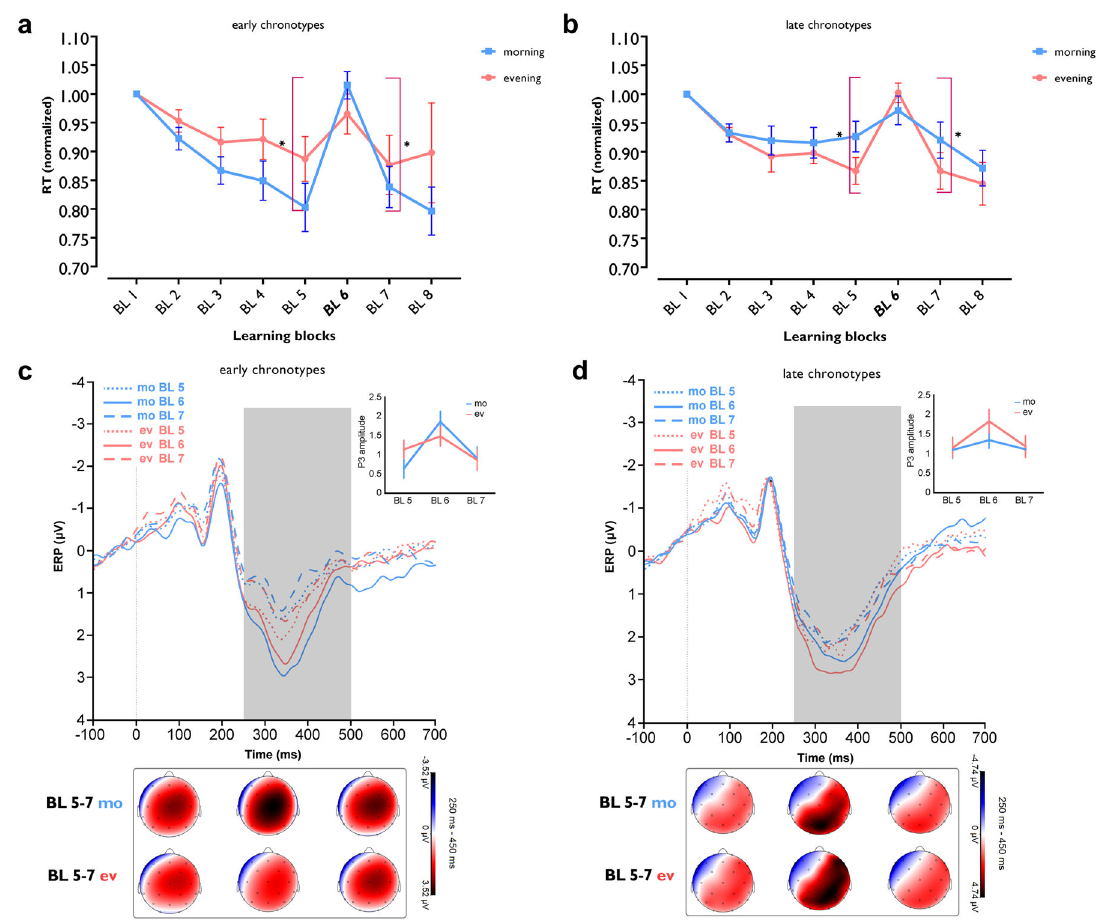
Fig. 4 Chronotype affects motor learning performance and ERP correlates. Behavioral and electrophysiological data were analyzed using a mixed- factorial design with repeated measures ANOVA (see Table 3). a , b The RT difference between blocks 6 – 5 mostly exclusively represents sequence learning. In ECs, the RT difference between these blocks was signi fi cant both in the morning and evening ( t morning = 5.70, P < 0.001, t evening = 2.93, P = 0.010), but blocks 6 – 5 RT difference in the morning vs evening was signi fi cantly larger ( t = 2.90, P = 0.012). In LCs, the respective RT difference was signi fi cant both in the evening and morning ( t evening = 8.78, P < 0.001; t morning = 2.40, P = 0.029), and blocks RT difference was signi fi cantly larger in the evening vs morning ( t = 2.72, P = 0.016). The RT difference between blocks 6 and 7 was signi fi cant in the morning and evening for both ECs ( t morning = 5.53, P < 0.001; t evening = 3.39, P = 0.004) and LCs ( t evening = 5.06, P < 0.001; t morning = 2.43, P = 0.028). Blocks 6 – 7 RT difference in the morning vs evening was only marginally signi fi cant for LCs ( t = 2.11, P = 0.052). Asterisks [*] represent s t atistically signi fi cant differences between learning blocks RT (BL 6-5, BL 6-7]. The brackets refer to RT difference between blocks 6 vs 5 and 6 vs 7 in the morning for ECs and evening for LCs. c , d The P300 component of electrode Pz was calculated per block in both groups. Pairwise comparisons show that ECs displayed a signi fi cantly larger P300 at block 6 vs block 5 in the morning ( t = 4.63, P < 0.001) vs evening ( t = 1.29, P = 0.198), whereas LCs showed reversed results in the evening ( t = 3.22, P = 0.001) vs morning ( t = 1.18, P = 0.239). The P300 positivity of electrode Pz was signi fi cantly reduced at block 7 vs block 6 in ECs ( t morning = 3.62, P < 0.001; t evening = 2.33, P = 0.022) and LCs ( t = 1.11, P = 0.269; t = 3.07, P = 0.002) at their circadian-preferred time. All pairwise comparisons in panels. a – d morning evening are calculated using Student ’ s t test ( P < 0.05, two-tailed, non-corrected). n = 31 (15 ECs, 16 LCs; data of one EC participant are excluded due to sequence awareness). Data are presented as mean values ± SEM. RT reaction time, BL block, mo morning, ev evening, P3 P300 component, ms milliseconds, ERP event-related potential, µ V microvolt, ECs early chronotypes, LCs late